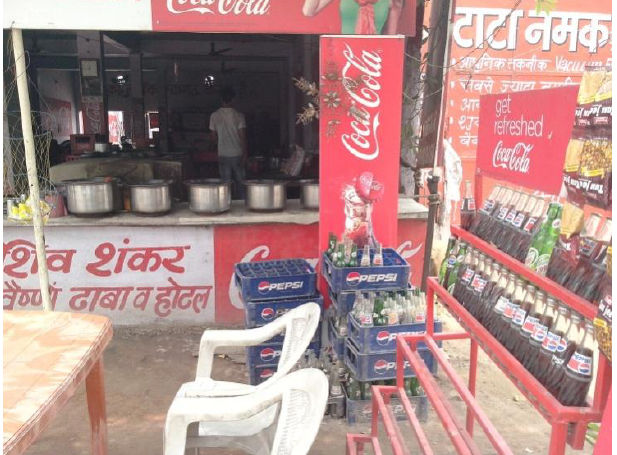
Figure 7. Bottles of sugar-sweetened beverages stacked outside a small shop ( dhaba ) on the national highway (NH-58), 60 km from